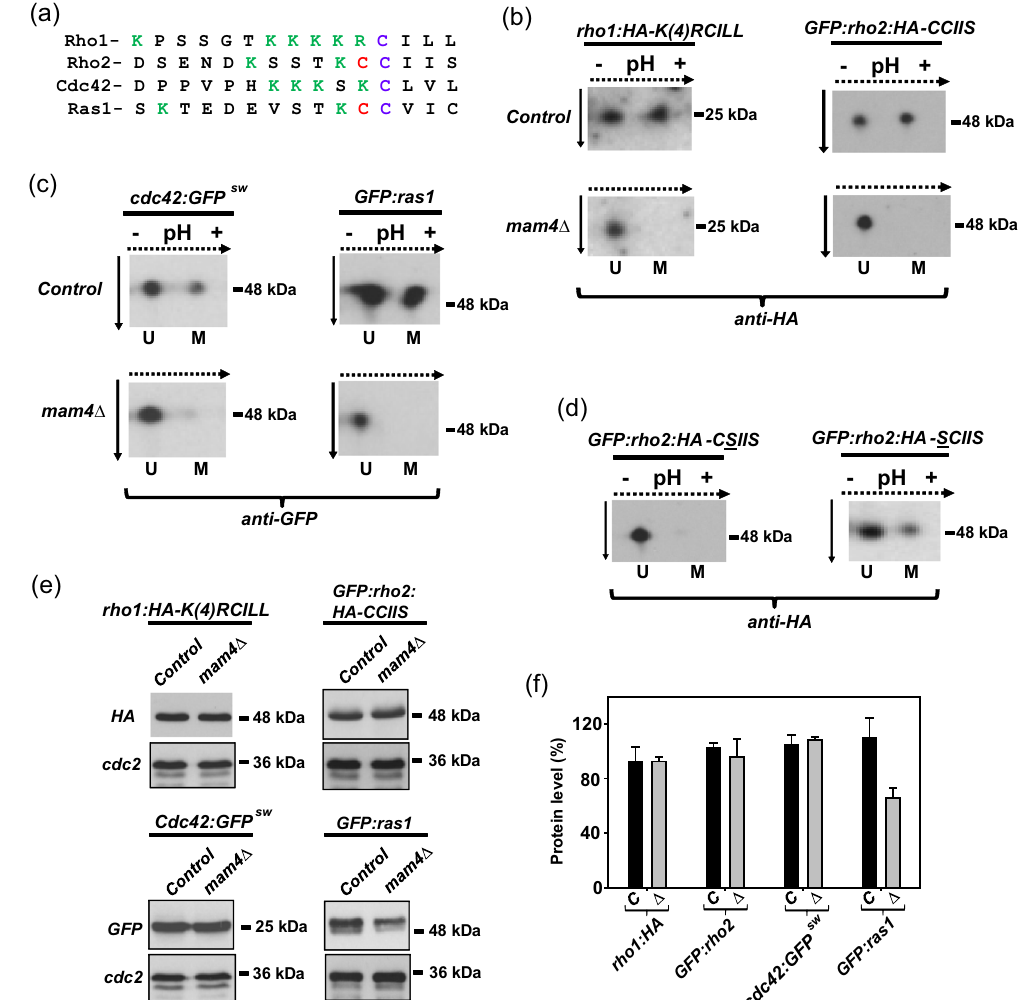
Figure 1. Mam4 I mediates cysteine methylation of Ras1 and Rho GTPases in fission yeast. ( a ) C-terminal sequences present in fission yeast GTPases Rho1, Rho2, Cdc42 and Ras1. Prenylated and palmitoylated cysteine residues are marked in blue and red, respectively. Positively charged residues are shown in green. ( b ) Cell extracts from control and mam4 ∆ strains expressing Rho1-HA-K(4)RCILL or GFP-Rho2-HA-CCIIS fusions were subjected to isoelectric focusing and immunoblot analysis with anti-HA antibody. Results representative of two independent experiments are shown. U: unmethylated GTPase; M: methylated GTPase. Dotted arrows: direction of IEF; solid arrows: direction of SDS-PAGE separation. ( c ) Cell extracts from control and mam4 ∆ strains expressing genomic Cdc42-GFP SW or GFP-Ras1 genomic fusions were subjected to isoelectric focusing and immunoblot analysis with anti-GFP antibody. Results representative of two independent experiments are shown. U: unmethylated GTPase; M: methylated GTPase. Dotted arrows: direction of IEF; solid arrows: direction of SDS-PAGE separation. ( d ) Cell extracts from strains LSM502 (GFP-Rho2-HA-CSIIS ; unprenylated GTPase) and LSM501 (GFP-Rho2-HA-SCIIS ; unpalmitoylated GTPase), were analyzed as described in ( b ). ( e ) Cell extracts from growing cultures in YES medium of strains with the indicated genotypes were resolved by SDS-PAGE and hybridized separately with anti-GFP and anti-Cdc2 (loading control) antibodies. Results representative of two independent experiments are shown. ( f ) Quantification of protein levels (as mean ± SD) of GFP-GTPase fusions shown in ( e ). Black bars: control cells; gray bars: mam4 ∆